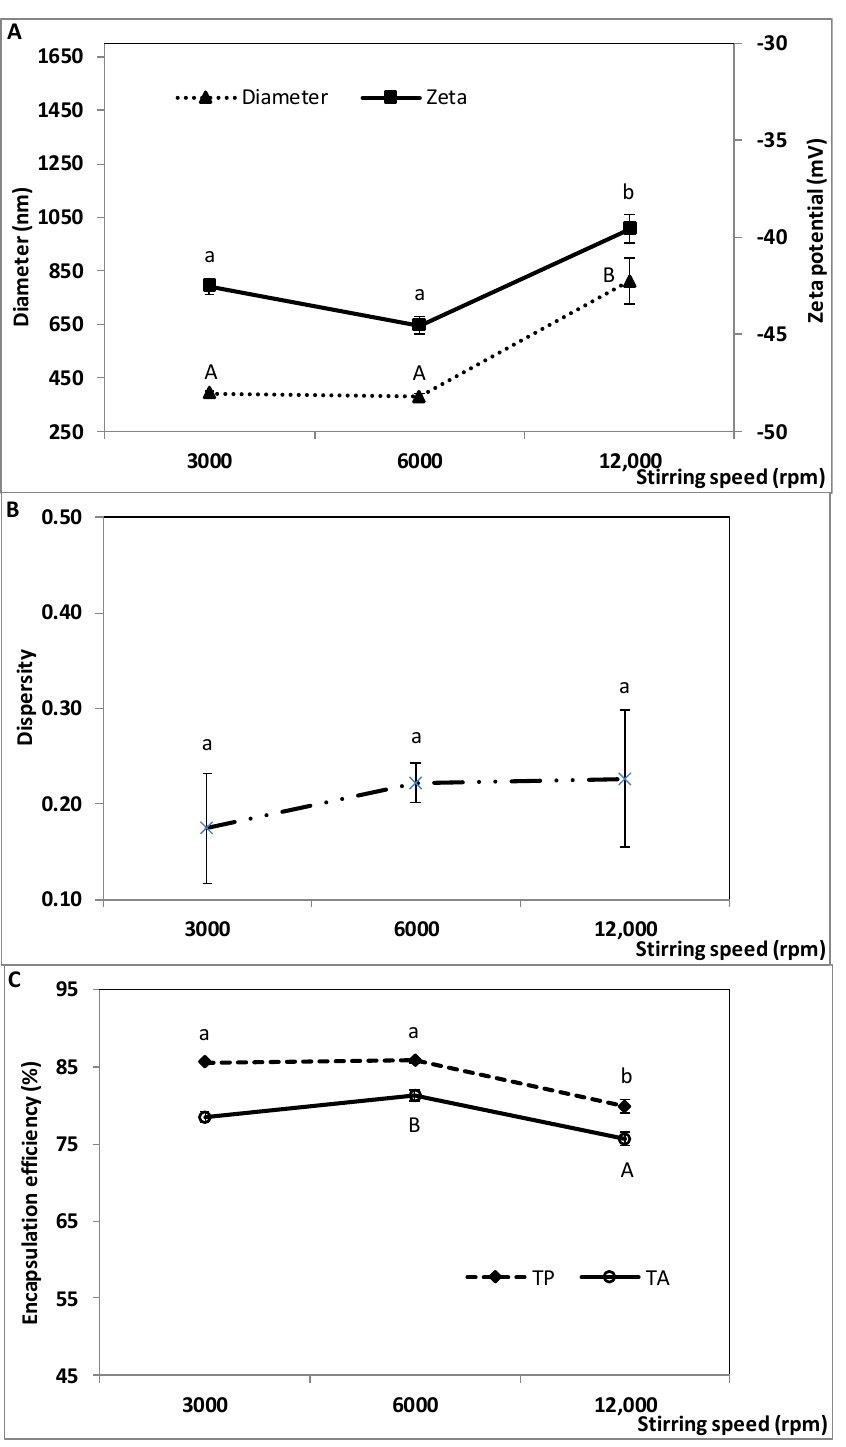
Figure 2. Effect of W 1 /O/W 2 homogenization stirring speed on the characteristics of the double emulsion, ( A ) droplet diameter, zeta potential, ( B ) size dispersity, and ( C ) encapsulation efficiency of total polyphenols (TP) and total anthocyanins (TA). W 1 /O homogenization speed and time: 10,000 rpm and 10 min; W 1 /O/W 2 homogenization time and microfluidization pressure: 15 min and 50 MPa. Means (three replicates) ± SD. Means with different letters in each series are significantly different ( p ≤ 0.05).